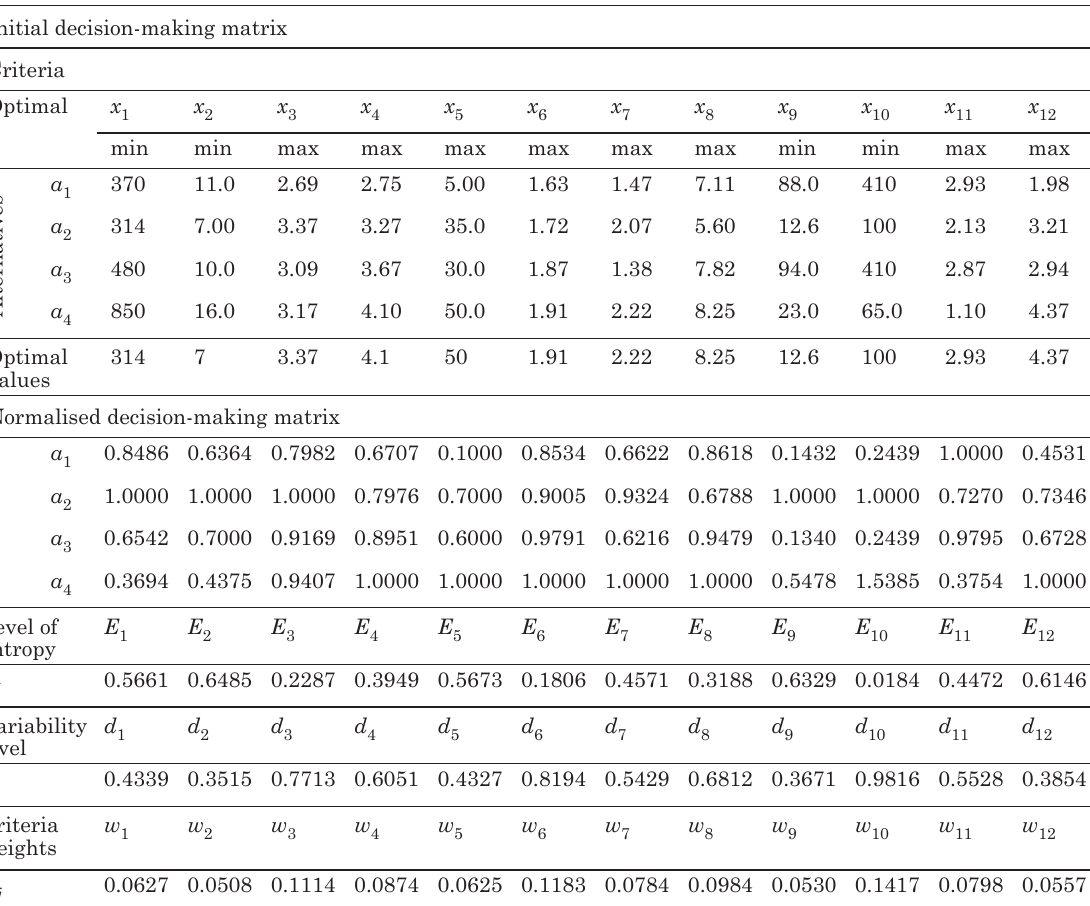
table 4. ranking of alternatives by applying the criterion of a mean-weighted success Initial decision-making matrix Criteria